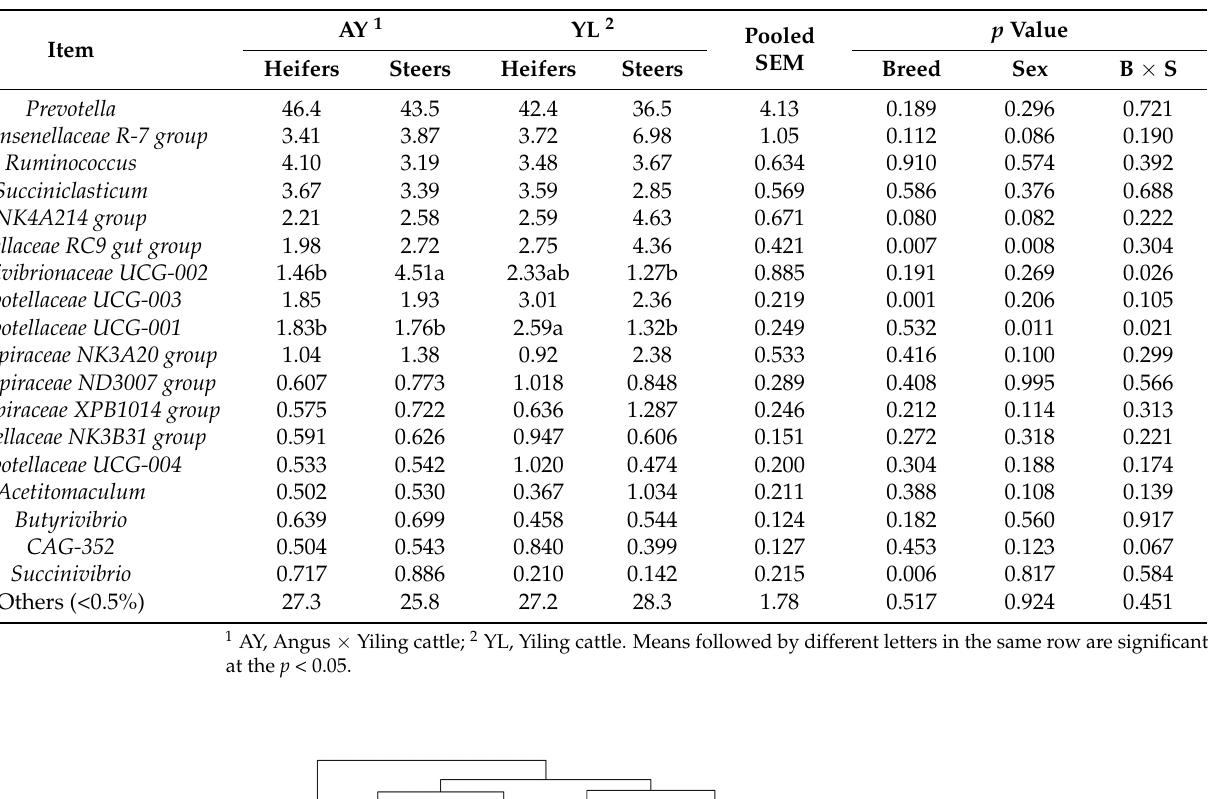
Table 6. Relative abundance of the dominant genus with an average relative abundance ≥ 0.5%.